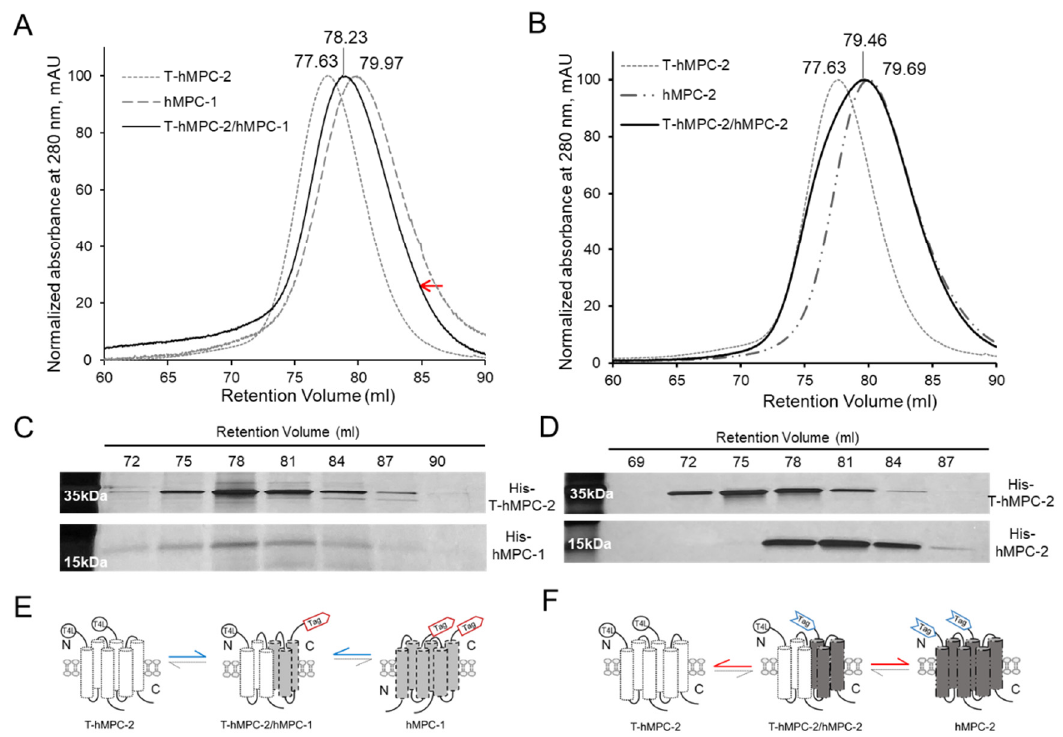
Figure 3. Hetero-complex formation between hMPC-1 and hMPC-2. ( A , B ) Analytical size-exclusion gel chromatography (aSEC) assay for identifying homo- and hetero-complexes of hMPCs. The monodisperse peaks of hMPC-1, hMPC-2, and T-hMPC-2 are represented by a dark gray dashed line, dash-double dotted line, and light gray dotted line, respectively. Both peaks of T-hMPC-2 / hMPC-1 and T-hMPC-2 / hMPC-2 are shown as a black line. The retention volumes of hMPC-1, hMPC-2, T-hMPC-2, T-hMPC-2 / hMPC-1, and T-hMPC-2 / hMPC-2 were 79.97 mL, 79.69 mL, 77.63 mL, 78.23 mL, and 79.46 mL, respectively. All aSEC analyses were performed using HiLoad Superdex 200 PG equilibrated with bu ff er containing 50 mM Tris-HCl (pH 7), 300 mM NaCl, and 0.05% ( w / v ) DDM. Absorbance was monitored at 280 nm. The peak shifting indicates by a red arrow. ( C , D ) SDS-PAGE analysis of eluted proteins across the retention volume (mL). The peaks containing T-hMPC-2 / hMPC-1 ( C ) and T-hMPC-2 / hMPC-2 ( D ) were isolated by each fraction separately, and protein contents were analyzed by SDS-PAGE. ( E , F ) Schematic diagram of the proposed process for the homo- and hetero-complexes of hMPC-1 and hMPC-2 based on the experimental setup. The higher strength of binding and dissociation constants about MPCs heterodimerization was highlighted in blue and red arrows, respectively.